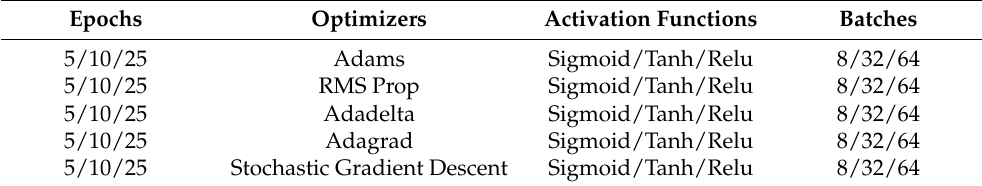
Table 2. Parametric tuning components and their respective variational combination table. Epochs Optimizers Activation Functions